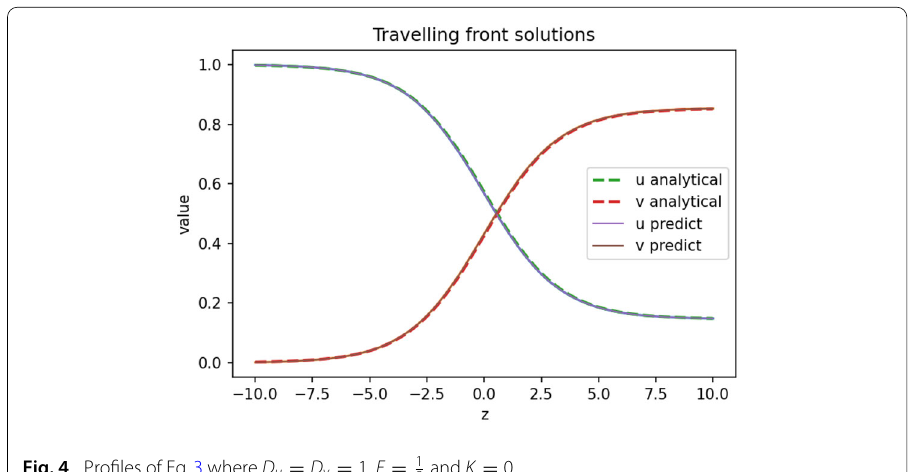
Fig. 4 Profiles of Eq.3 where D u = D v = 1, F = 1